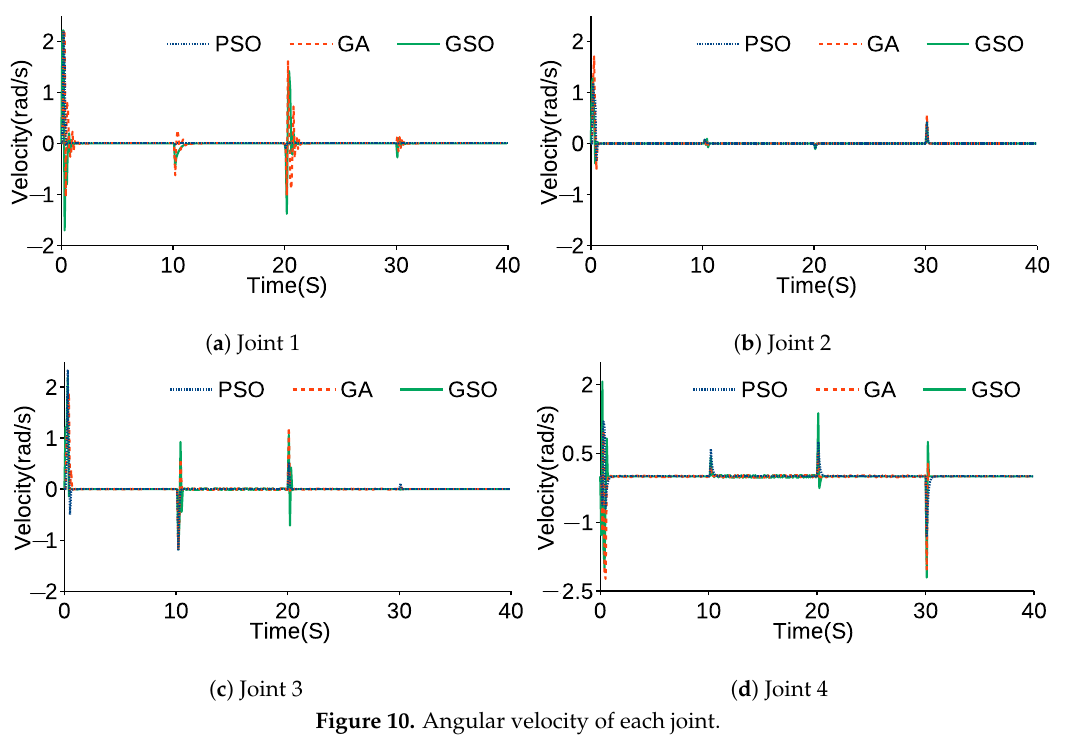
Figure 10. Angular velocity of each